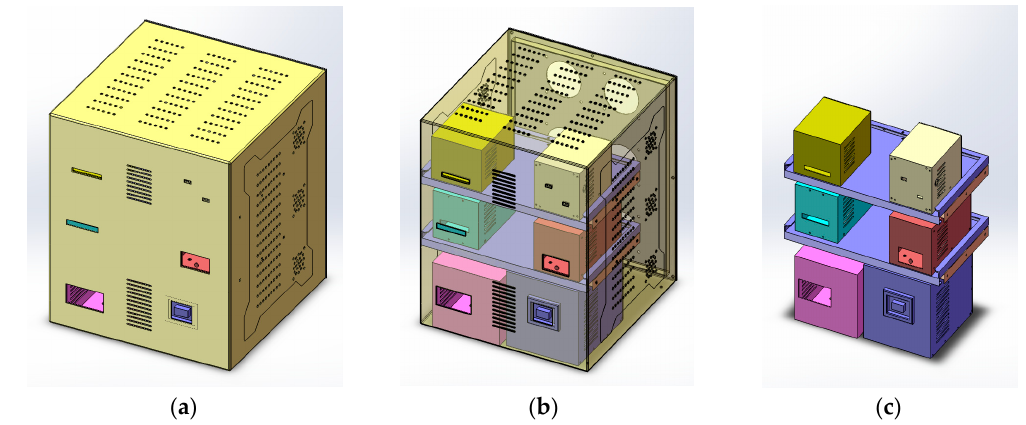
Figure 3. ( a ) The appearance of the instrument; ( b ) The perspective view of the 3D model with six modules inside and six cooling fans at the backplane; ( c ) The internal configuration of the instrument.